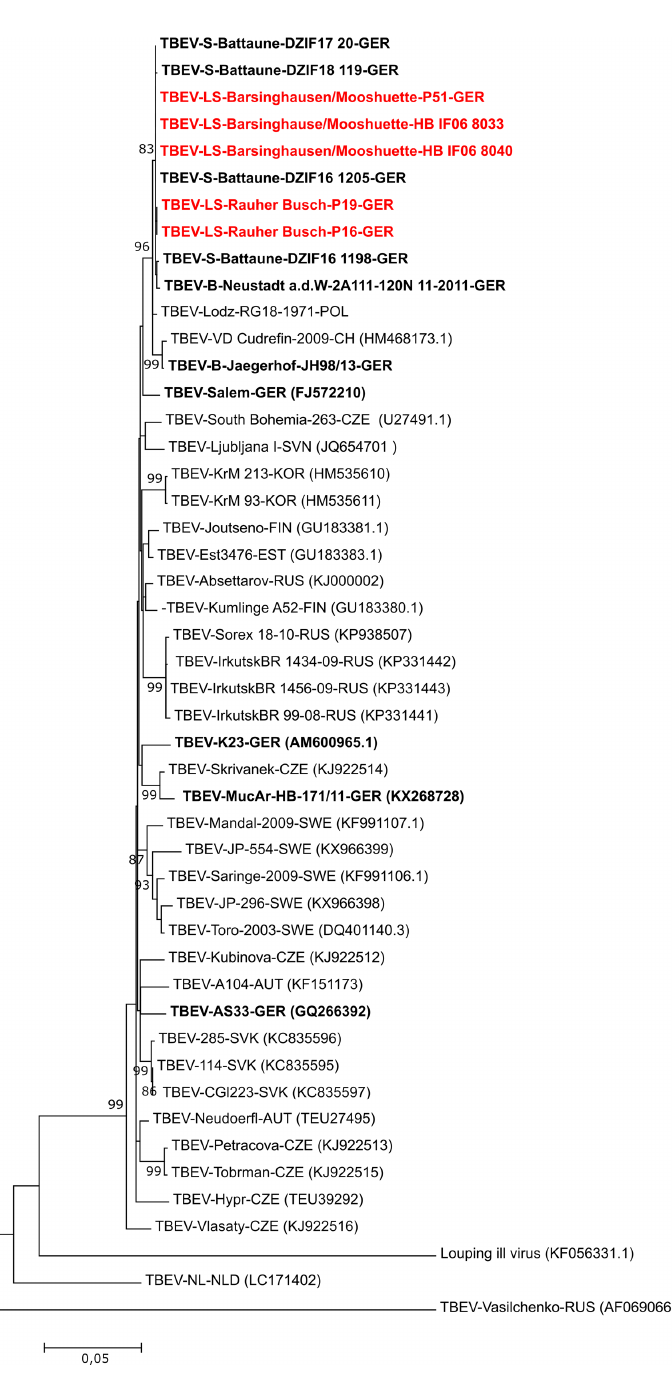
Figure 2. Phylogenetictree(MaximumlikelihoodTree, MEGA6.0)ofthefive“TBEV-LS”isolatescollected in “Barsinghausen / Mooshuette” and “Rauher Busch” (TBEV-LS-Rauher Busch-P16 (MK903683), -P19 (MK903681) and TBEV-LS-Barsinghausen / Mooshuette-P51 (MK903682), -HB IF06 8040 (MK903679) and –HB IF06 8033 (MK903680) in the German federal state of Lower Saxony, 2018, using E gene sequences. Virus isolate names are given as follows: TBEV-isolate name or number-three letter country code according to UN standard (accession number of the sequence as available from NCBI). UN country codes are: AUT: Austria; CHE: Switzerland; CZE: Czech Republic; EST: Estonia; FIN: Finland; GER: Germany; KOR: Korea; NLD: Netherlands; POL: Poland; RUS: Russian Federation; SVN: Slovenia; SVK: Slovakia; SWE: Sweden. As an outgroup strain Louping ill virus (KF056331.1), TBEV-NL (LC171402) and TBEV-Vasilchenko (AF069066) were used. All sequences obtained from German isolates are marked bold, the new sequences obtained during this study are additionally marked in